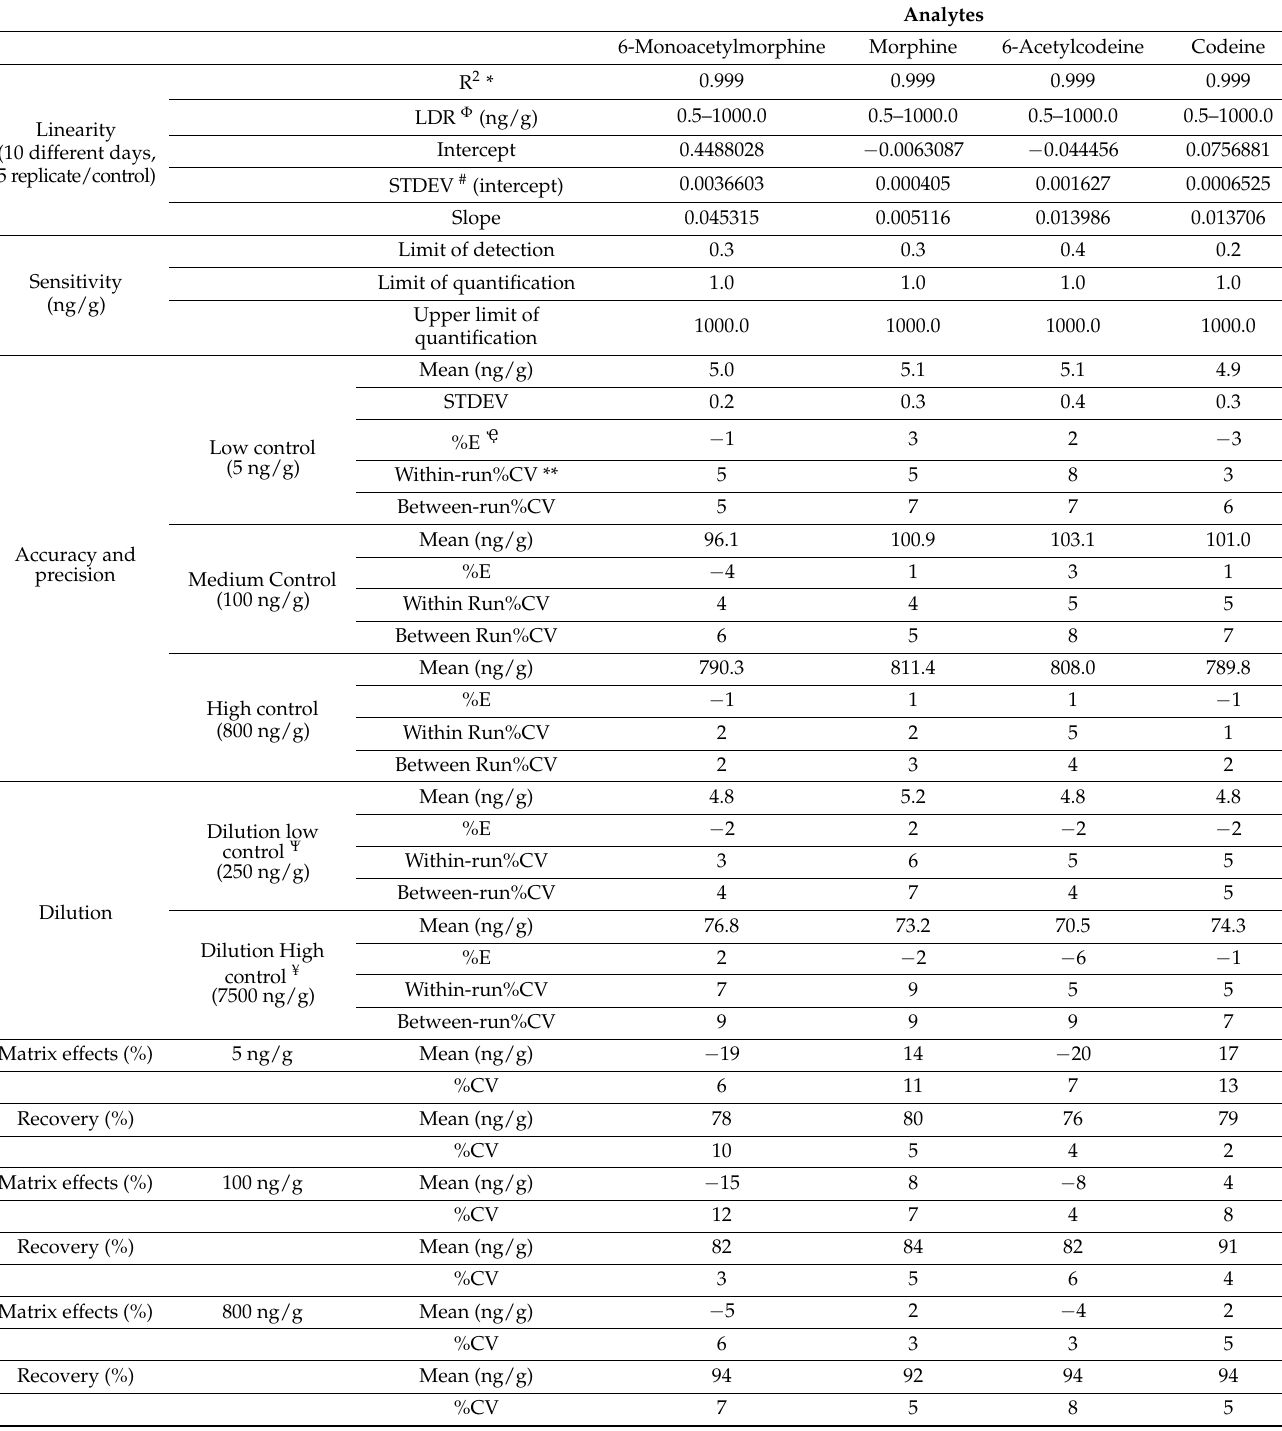
Table 2. LC-MS/MS data for heroin biomarkers, morphine, and codeine.